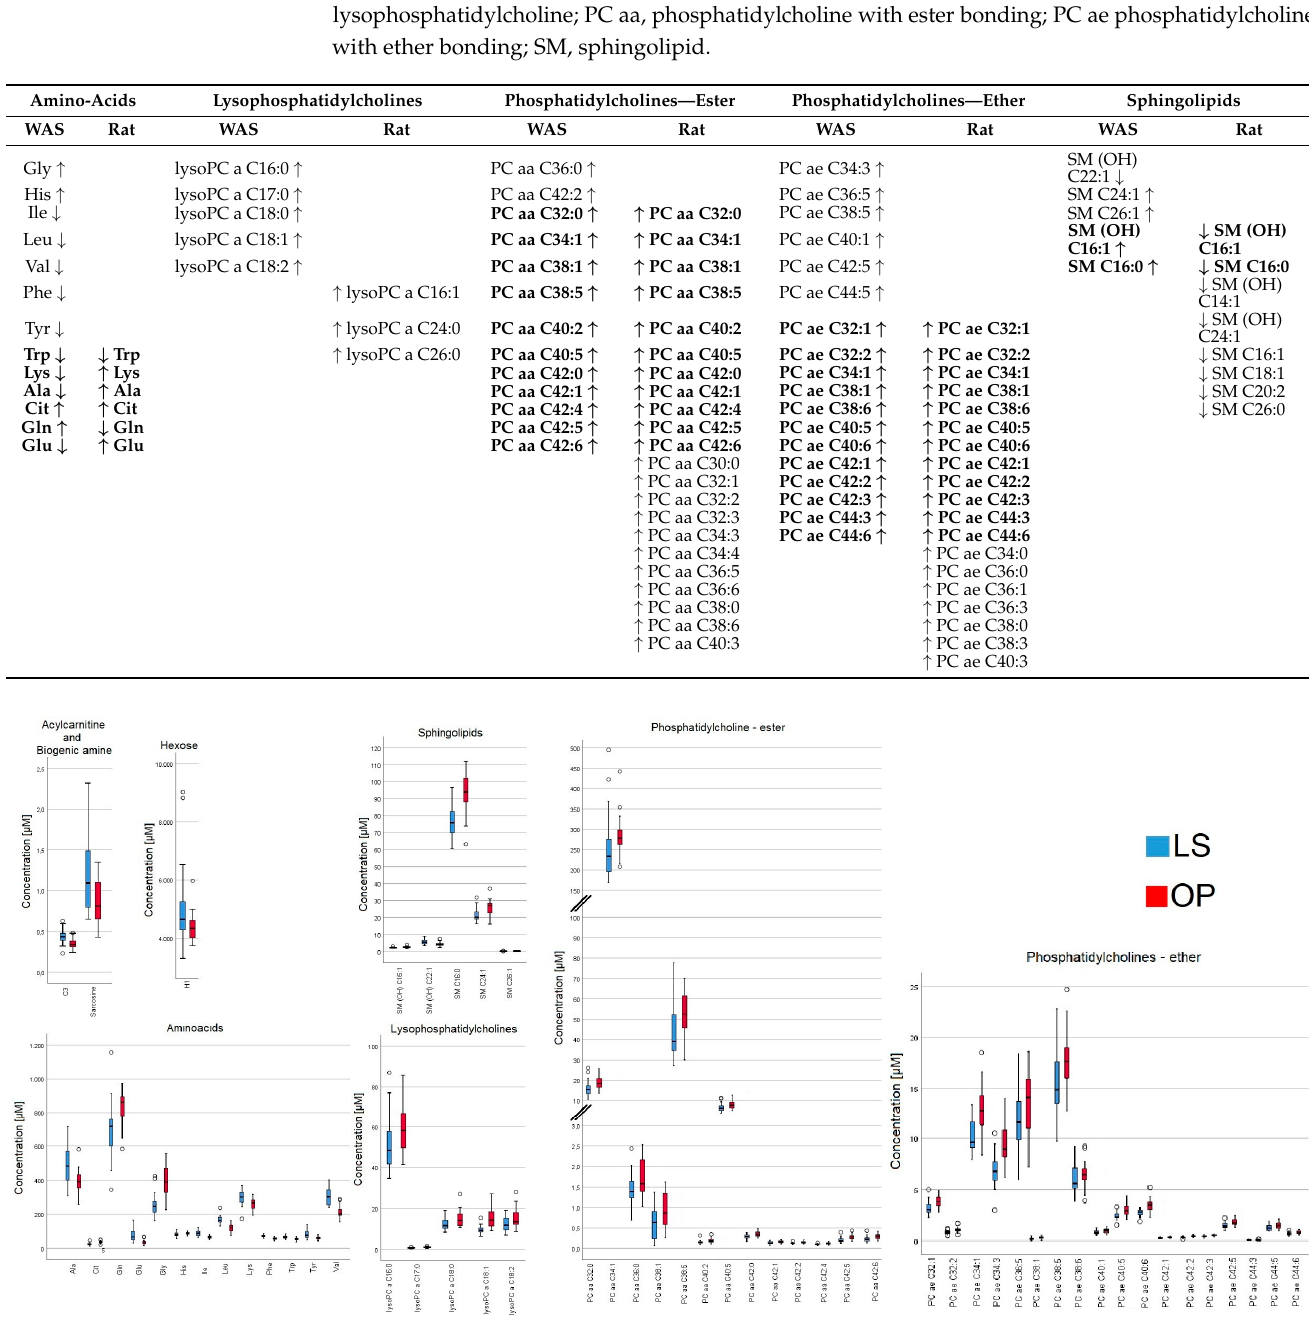
Figure 5. Metabolomic profile of 57 significantly different metabolites of acylcarnitines; amino acids; lysophosphatidylcholines; sphingolipids; acylcarnitines; biogenic amines; phosphatidylcholines with ester bonding; phosphatidylcholines with ether bonding; hexose, between lifestyle (LS) and RYGB (OP) group at one-year follow-up. Five of these PCs are characterized by forty-two carbon atoms (PC aa C42:Y): PC aa C42:0 (0.29 µM in LS vs. 0.35 µM in OP; 0.06 µM in BWM_rat vs. 0.10 µM in RYGB_rat),